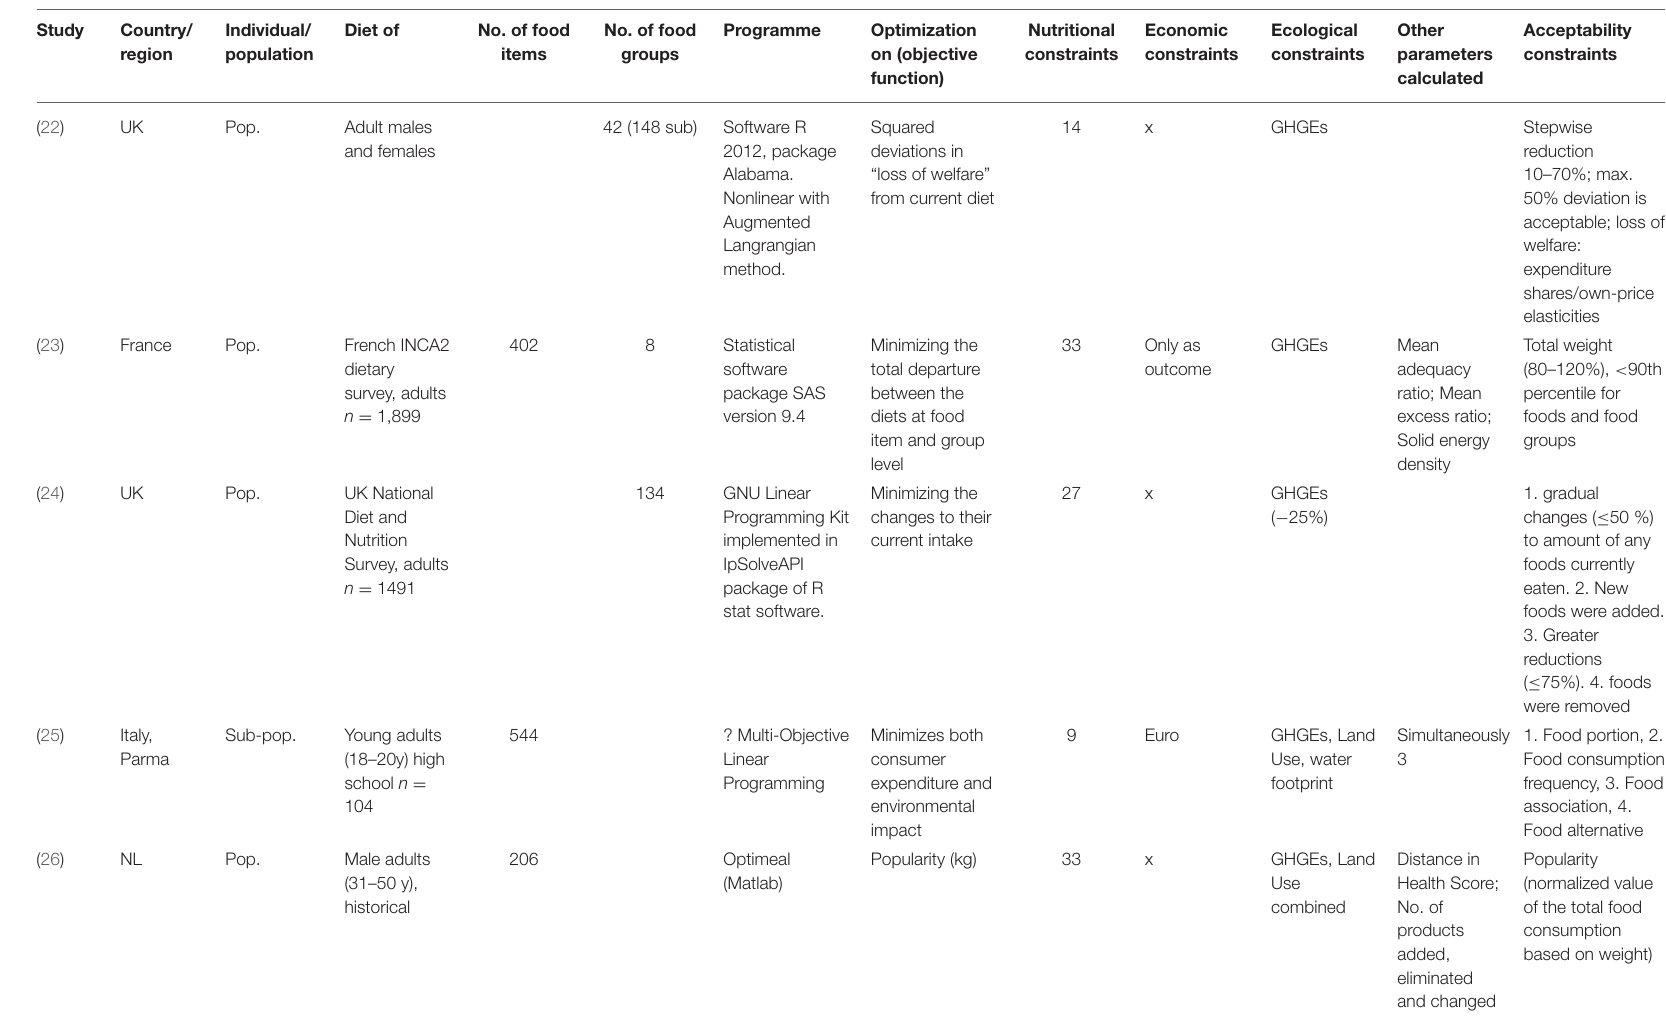
The table gives details about the goal, objective function, selected population group, program, number of food items, and